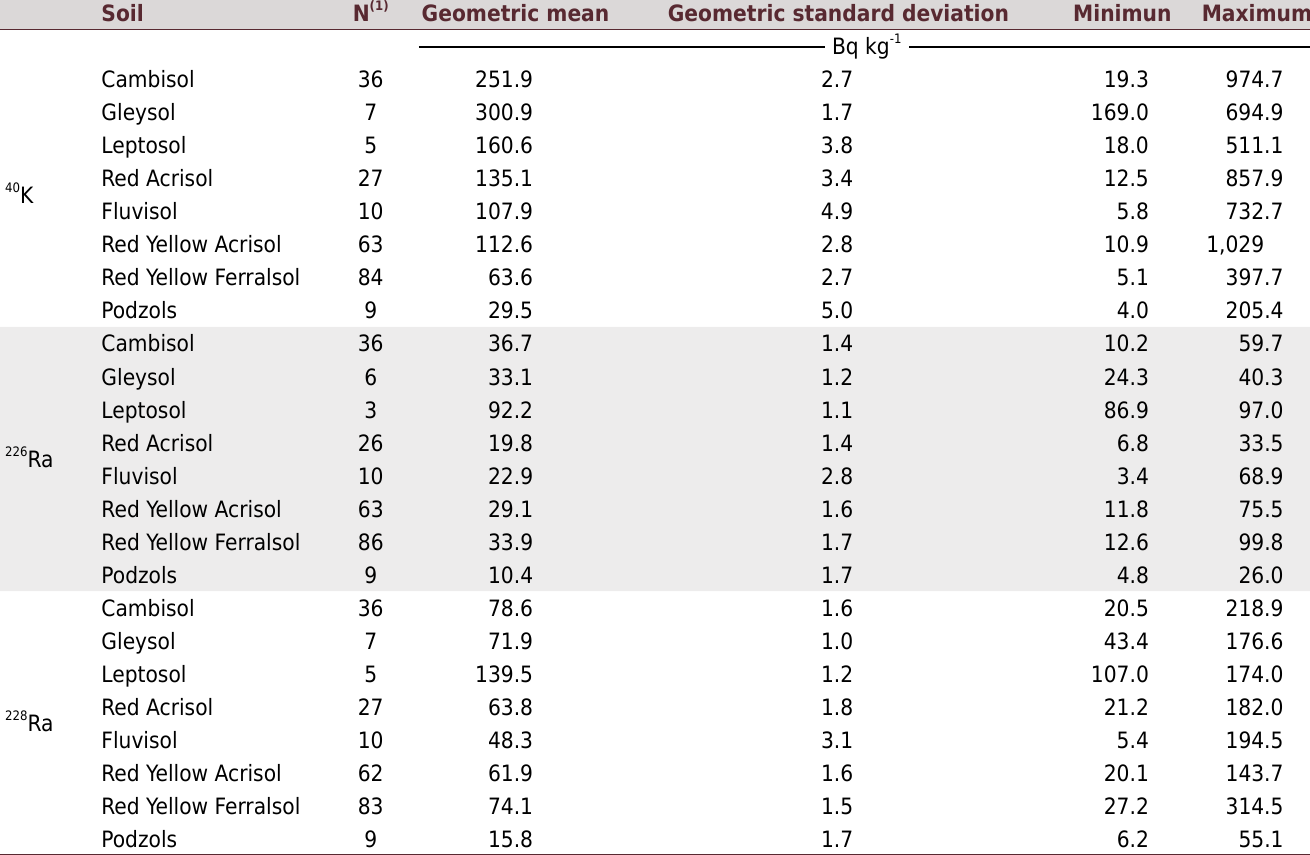
Table 6. Statistical summary of activity concentrations (in Bq kg -1 ) of radionuclides in the different soil types Soil